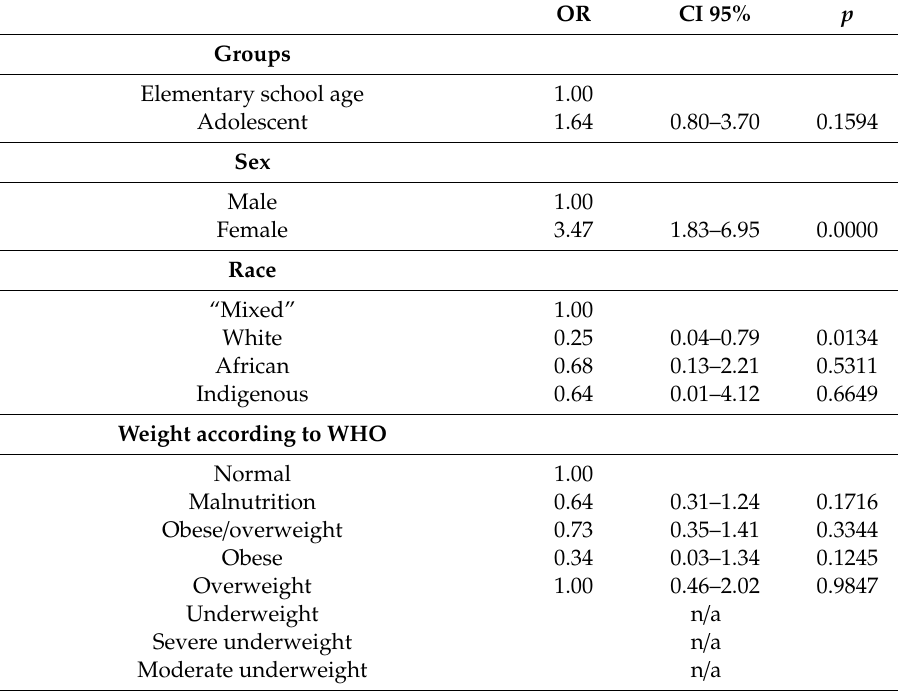
Table 2. Children diagnosed with functional abdominal pain disorder by Rome IV criteria compared to control group of children without a functional gastrointestinal